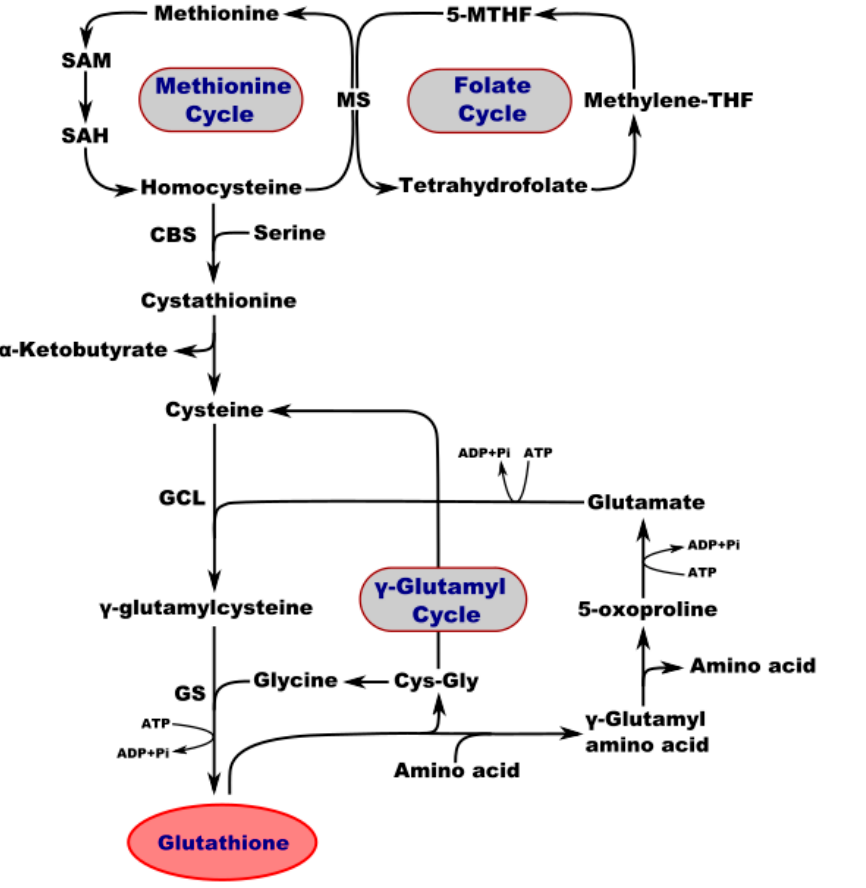
Figure 1. Interconnection of metabolic and synthetic pathways of GSH. SAM—S-adenosylmethio- nine; SA—S-adenosylhomocysteine; MS—methionine synthase; 5-MTHF—5-methyltetrahydrofolate; Methylene-THF—methylene tetrahydrofolate; CBS—cystathionine b-synthase; GCL—glutamate-cysteine ligase; GS—GSH synthetase; CysGly—cysteine-glycine.